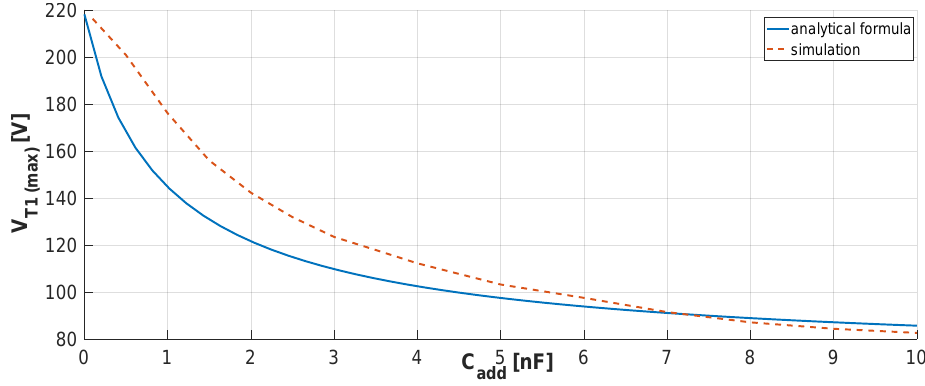
Figure 14. The overvoltage characteristic in the function of the snubber capacitor value: (—) calcu- lated with analytical formula from [10] and (- -) Saber@sketch